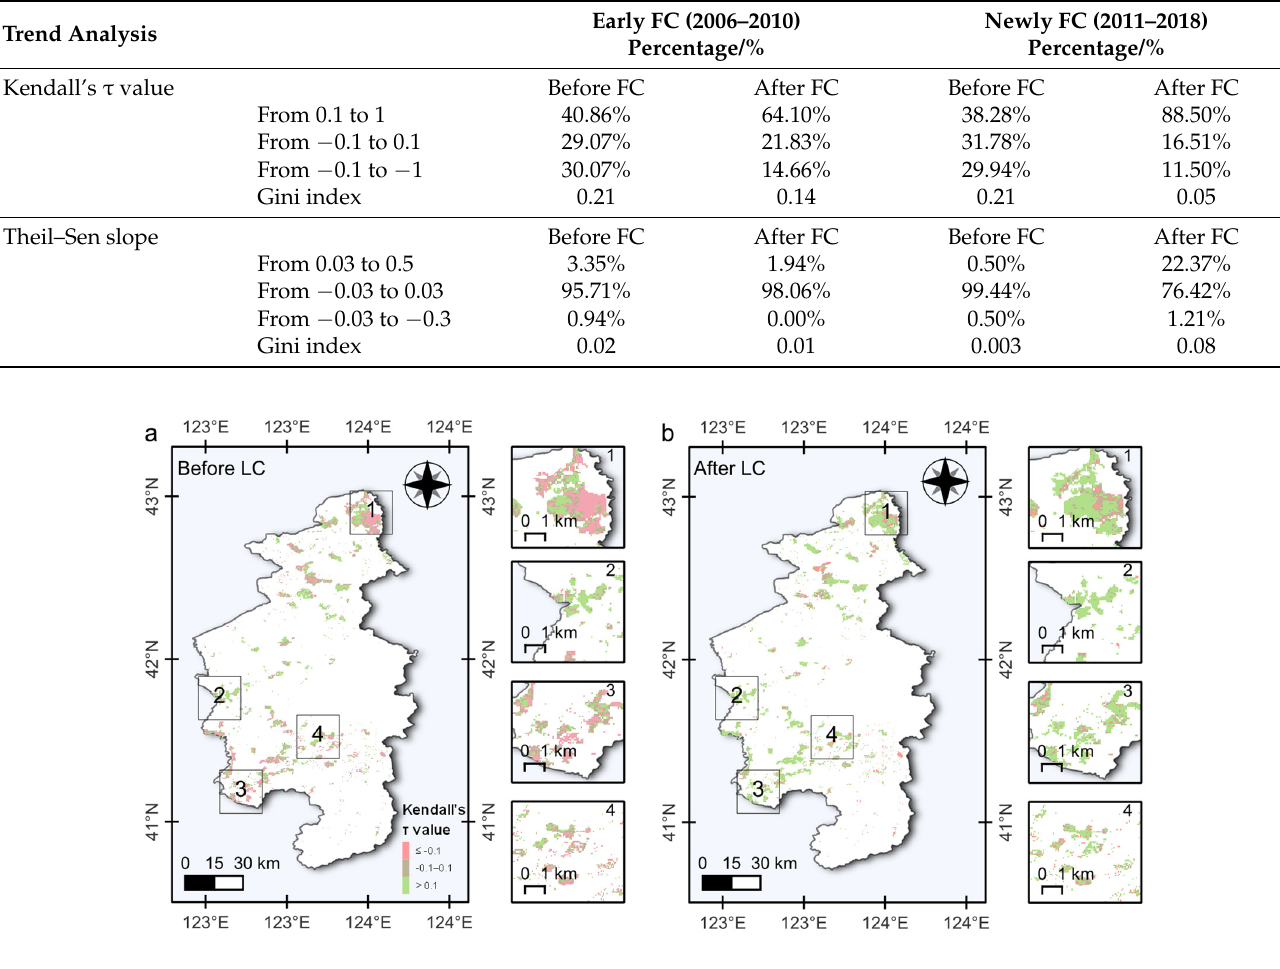
Figure 7. The trend of eco-environment quality (M–K test) in the FC areas at the 95% confidence level before FC ( a ) and after FC ( b ); the subsets (1–4) are used to reflect the changes.